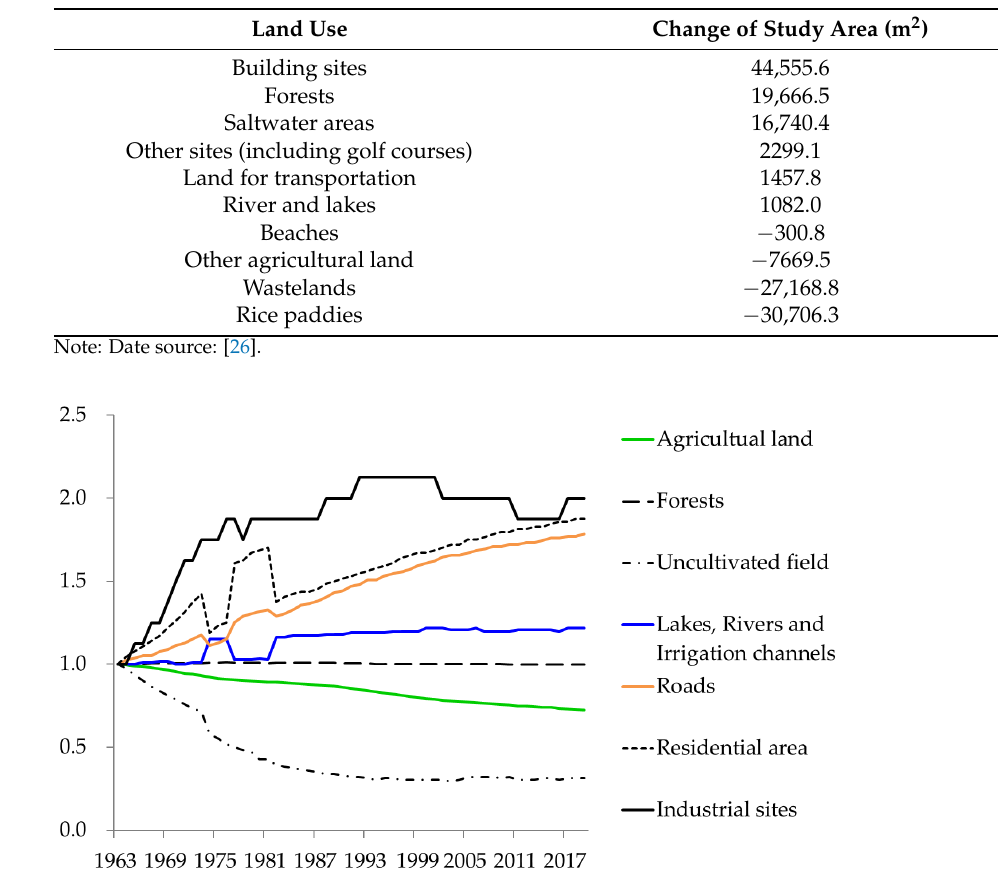
Figure 4. Changes in Land Use Classification in Japan; the baseline value of 1963 was set as 1 (Date source: [29]).